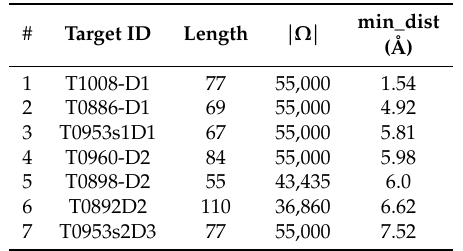
Table 2. Dataset collected from critical assessment of protein structure prediction data archive. The target IDs are shown in Column 2. The length of each sequence (number of amino acids) is shown in Column 3. The size of the Rosetta-generated decoy dataset (number of decoys) is shown in Column 4. The lowest RMSD to the known native structure in each dataset is shown in Column 5.